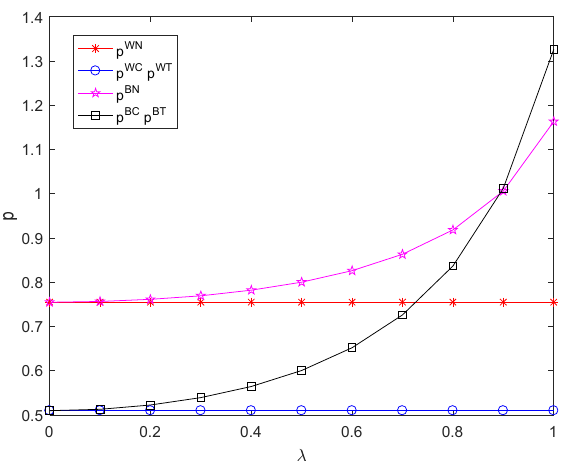
Figure 2. Sales price in different scenarios.